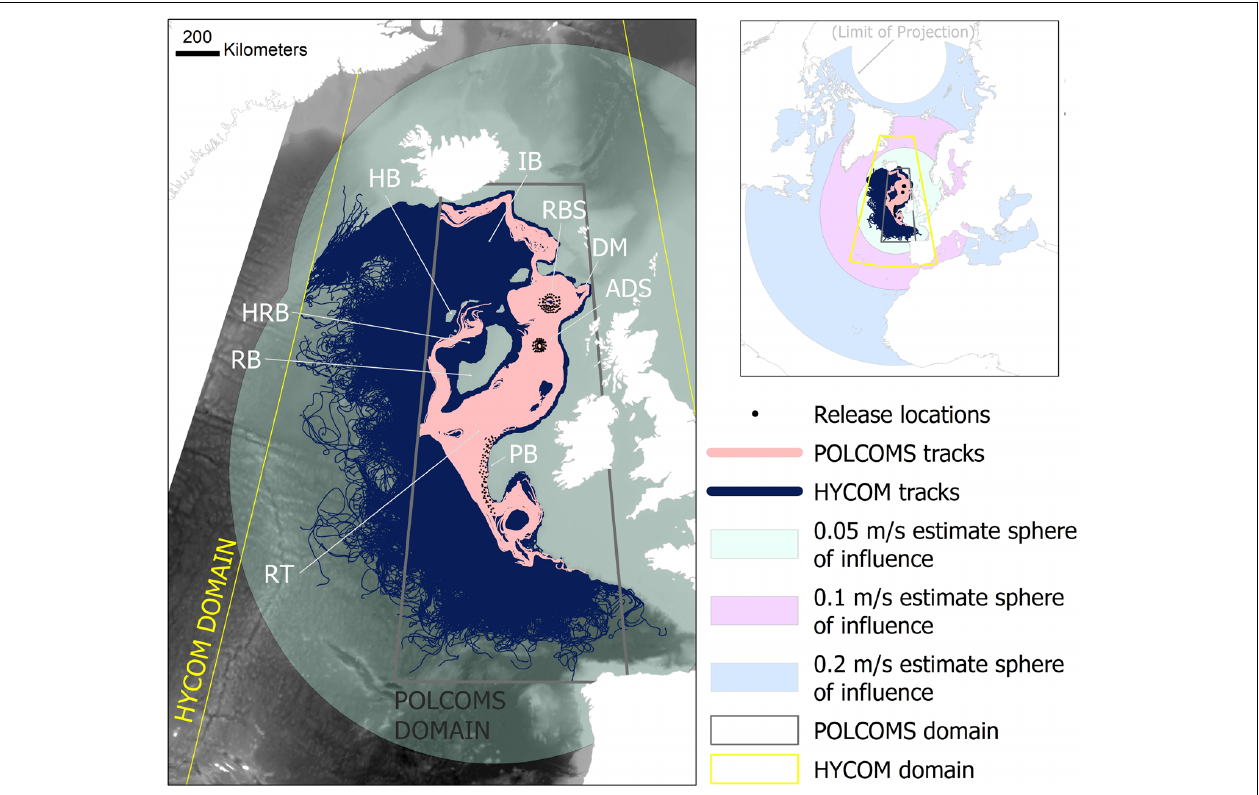
FIGURE 1 | Labeled plots of the study area locations, together with all simulated tracks in the HYCOM and POLCOMS larval dispersal models relative to the smallest sphere of influence predictions of an average current speed based estimate (0.05 m/s; main map), and relative to all three current speed based estimates (0.05, 0.1, 0.2 m/s; inset). The gray and yellow boxes delineate the domain of the POLCOMS model and simulation domain of the HYCOM model, respectively. Tracks simulated by each model were unable to exit these areas. Quantitative comparisons were limited to the POLCOMS domain. The theoretical “larvae” were released from Rosemary Bank (RBS), Anton Dohrn Seamount (ADS), and Porcupine Bank (PB) (highlighted with red boxes). Features of topography mentioned in the text are labeled as follows: Iceland Basin (IB), Hatton Bank (HB), Darwin Mounds (DM), Hatton Rockall Basin (HRB), Rockall Bank (RB), Whittard Canyon (WC), Bay of Biscay (BB). [This map was created in ArcGIS 10.6.1 (http://www.esri.com) with GEBCO 30 arc-second topography, available from www.gebco.net, and projected using Albers Equal Area Conic with modified standard parallels and meridian (sp 1 = 46 ◦ N, sp 2 = 61 ◦ N, m = 13 ◦ W)].